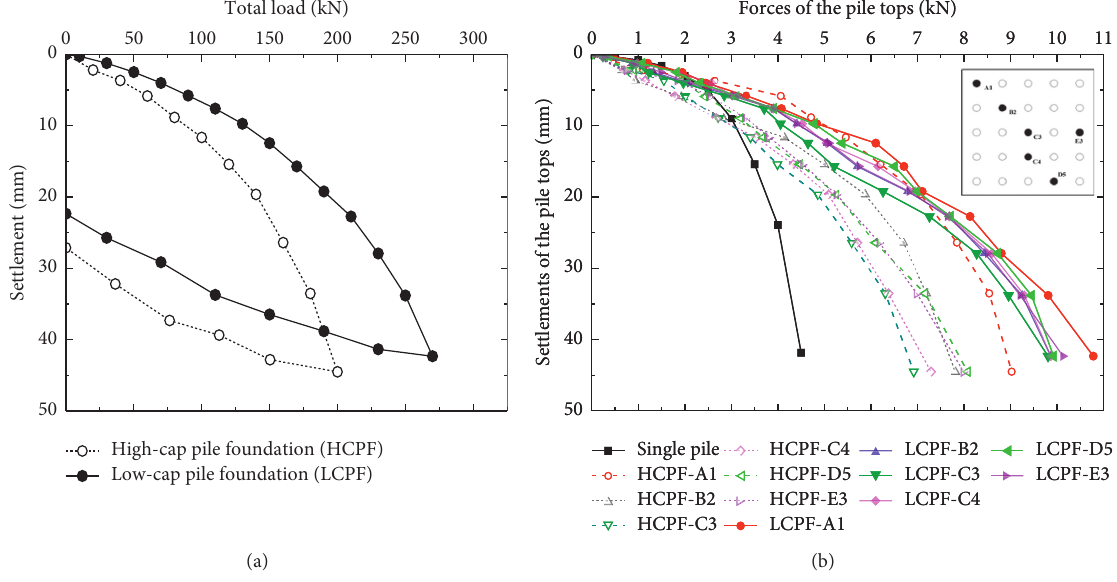
Figure 4: (a) The load settlement curves of the superlong pile foundation model tests. (b) The force settlement curves of the pile tops of the superlong pile